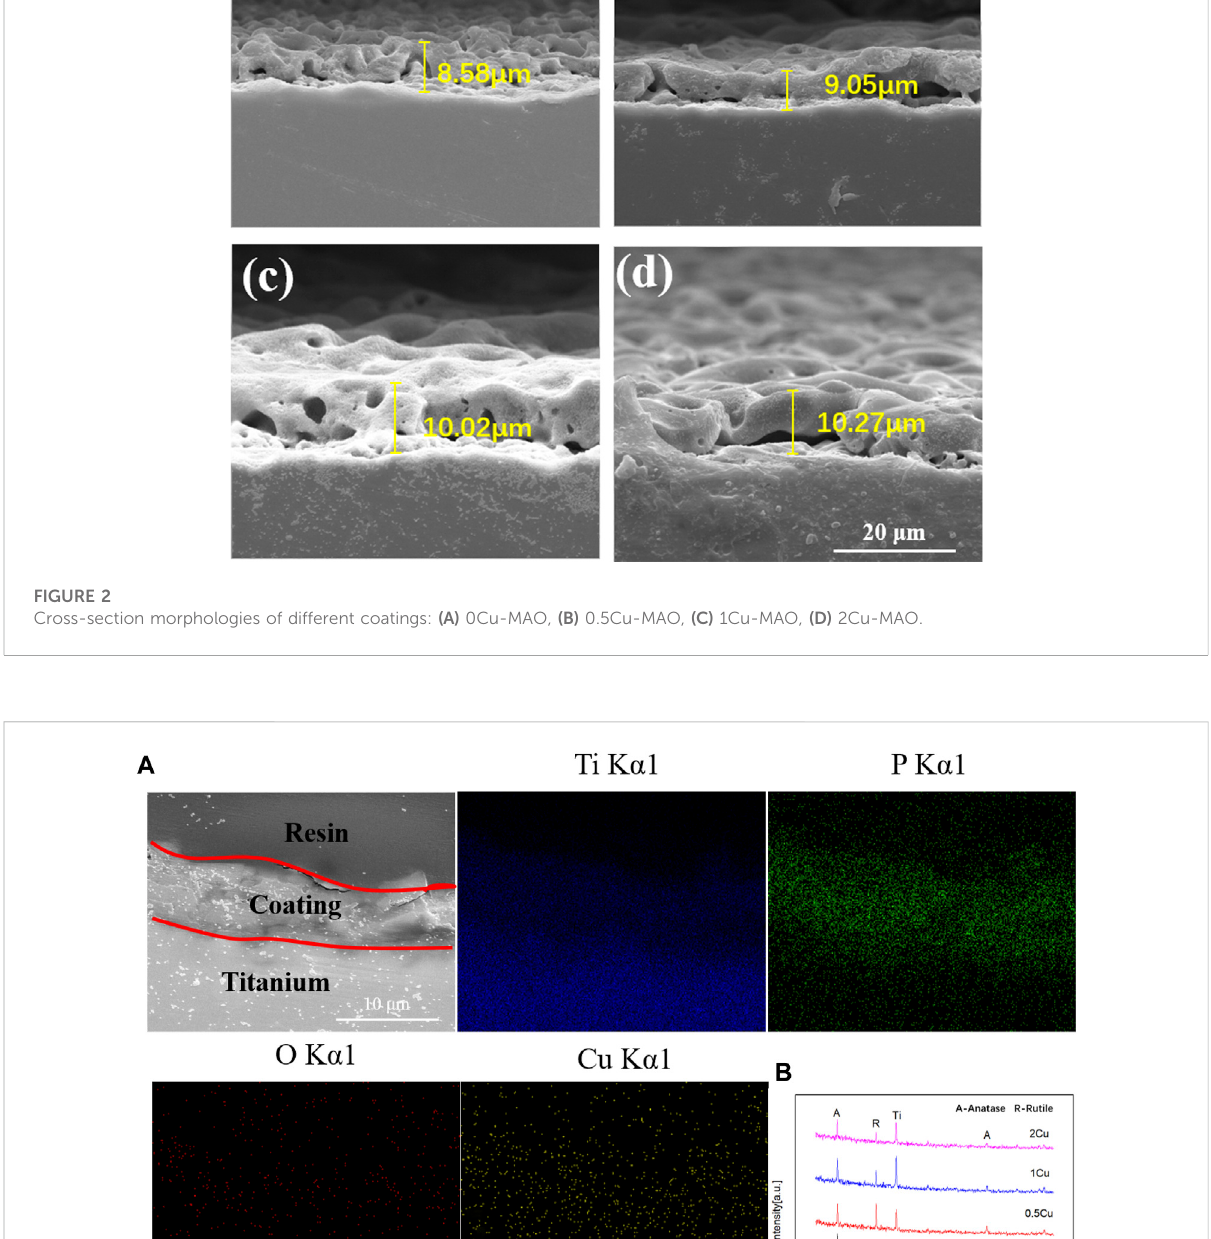
Frontiers in Bioengineering and